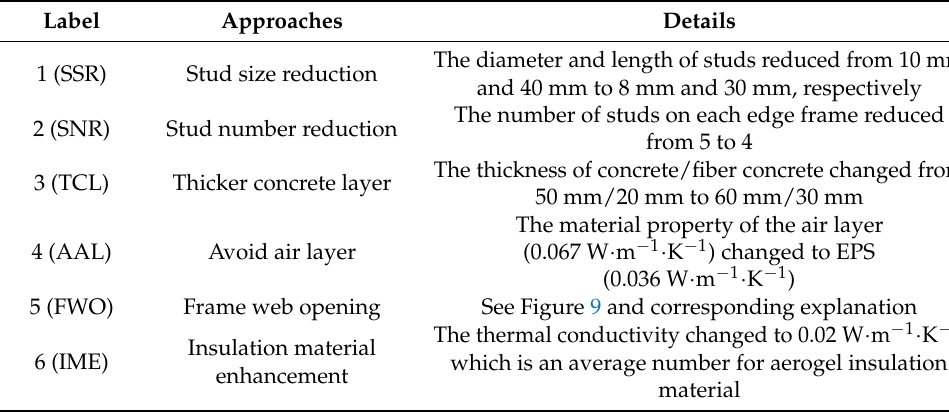
Table 7. Description of Improvement